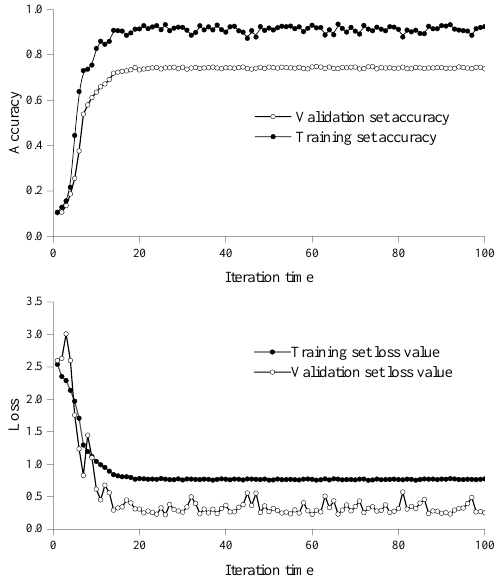
Figure 6. Lost and accuracy values without migration learning.